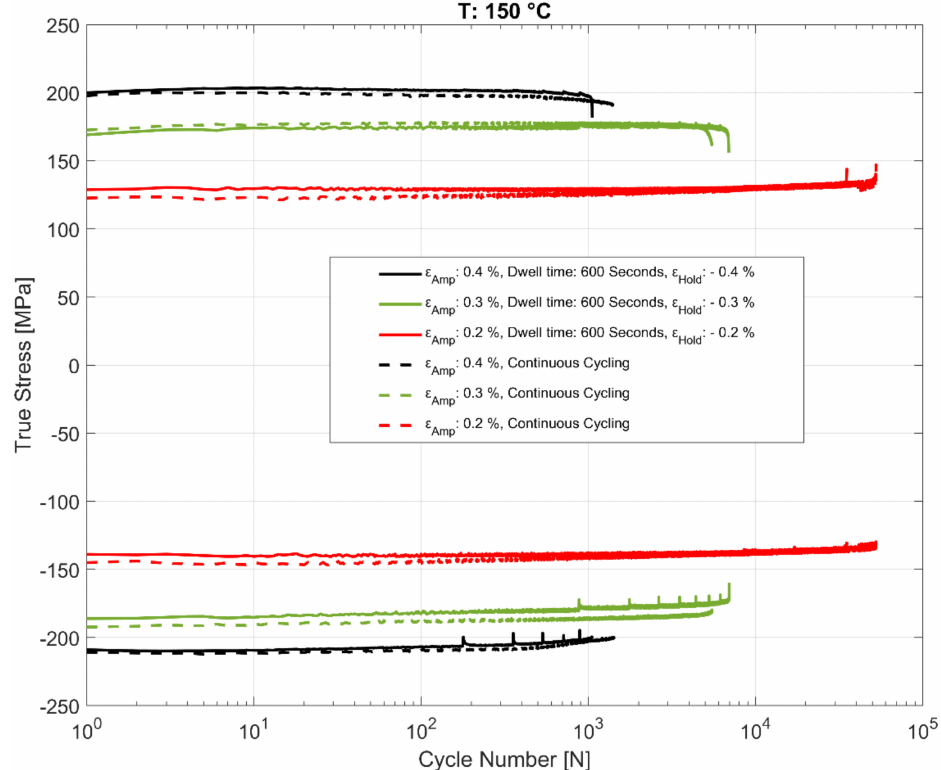
Figure 13. Evolution of peak and trough stress response in strain-controlled fatigue tests with and without hold time at 150 ◦